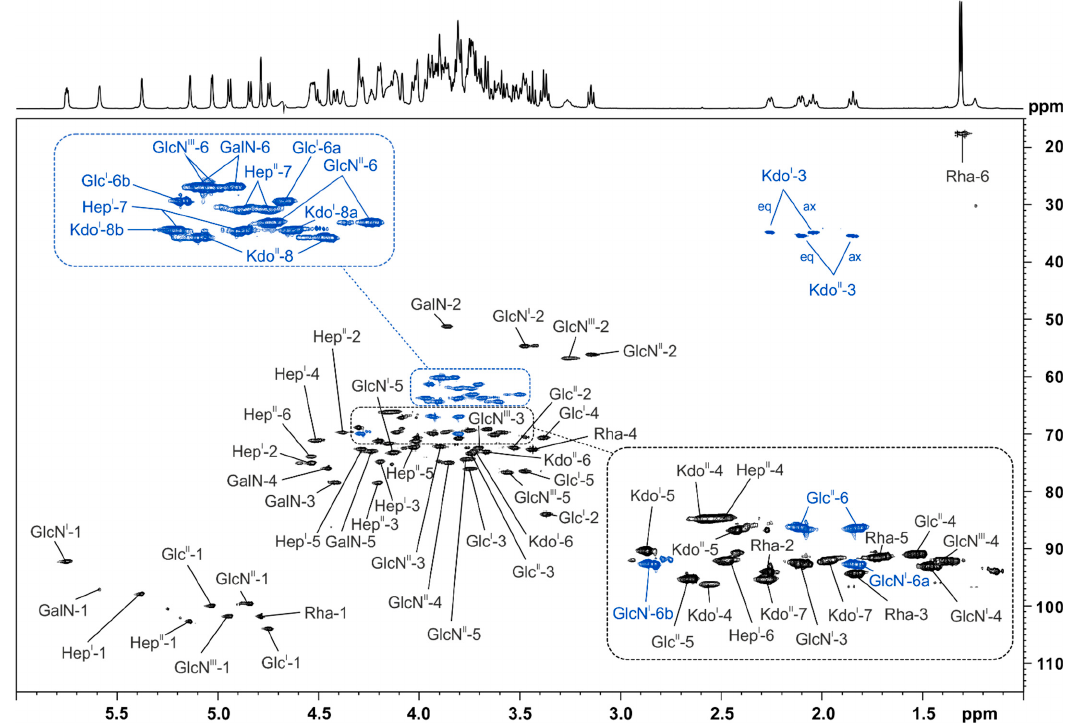
Figure 4. NMR analysis of the major O- and N-deacylated core-LA carbohydrate backbone molecule ( 1 ) of Pst DC3000 Δ wbpL after HPAEC-fractionation. Shown above is a section ( δ H 6.0–1.0; δ C 115–15) of the 1 H, 13 C-HSQC NMR spectrum, recorded at 310 K in D 2 O as dept-version (blue: CH 2 -groups, black: CH/CH 3 -groups), including assignment of signals. The corresponding NMR chemical shift data are listed in Tables 3–5. Table 2. Mass spectrometric analysis of the O- and N-deacylated core-LA carbohydrate backbone of Pst DC3000 Δ wbpL . Summary of calculated monoisotopic neutral masses and observed molecular masses [Da] in the OS-HyKOH preparation, Table 3. 1 H NMR chemical shift data of 1 recorded in D 2 O at 310 K. the corresponding MS spectrum is depicted in Figure 3a. Accuracy of the measurement is stated as Δ ppm; anh = anhydro.